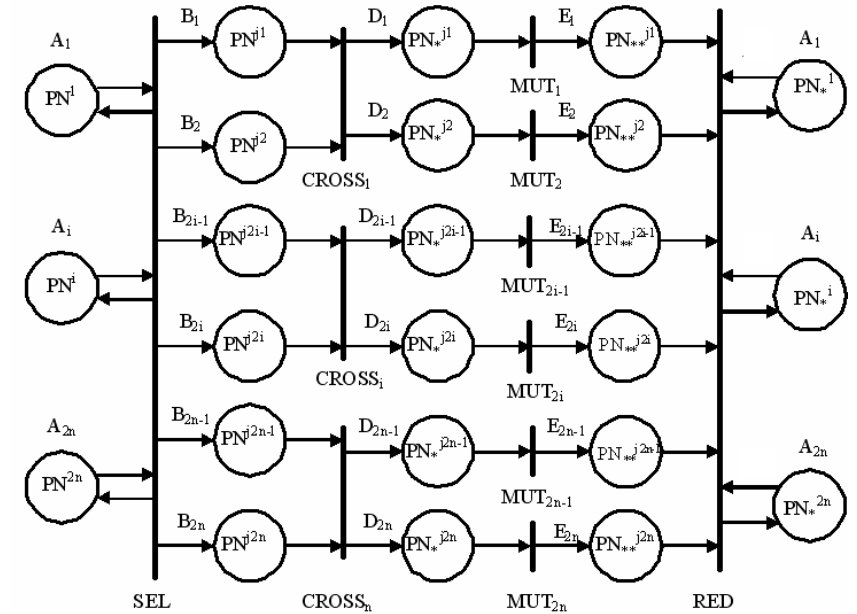
Figure 1. Model of a genetic algorithm based on Petri nets.